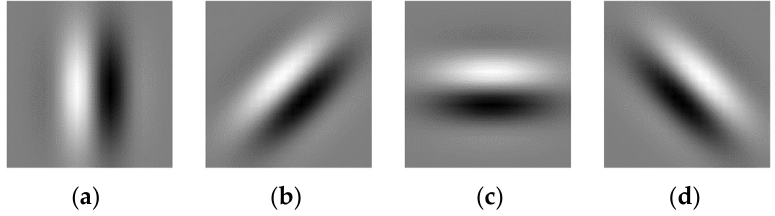
Figure 2. Display of four Gabor filters used in this research: ( a ) 90’, ( b ) 45’, ( c ) 0’, and ( d ) − 45’.